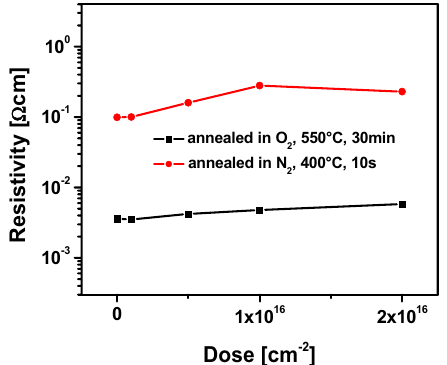
Fig. 1. Resistivity of N-implanted ZnO:Ga films, annealed in O 2 at 550 ◦ C for 30 min, and in N 2 at 400 ◦ C for 10 s, as a function of the